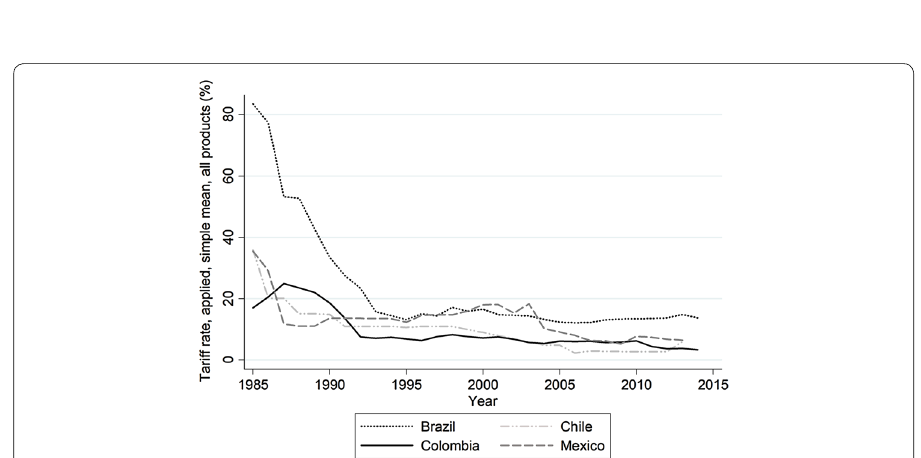
Fig. 5 Average effective tariffs. Source : Own calculations based on data from the World Bank